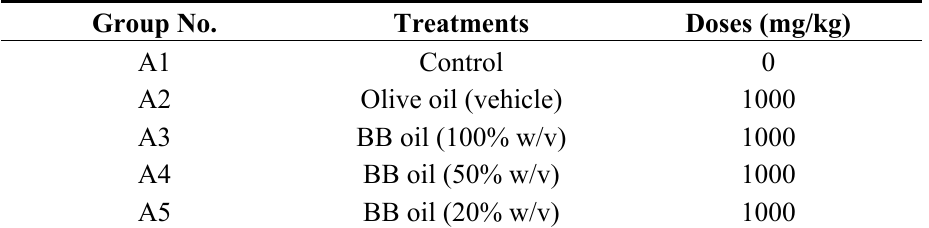
Table 2. Normal animal groups ( n = 5/group): treatments, doses and route of administration of different concentrations of volatile oil from Blumea balsamifera (BB oil) concentrations.